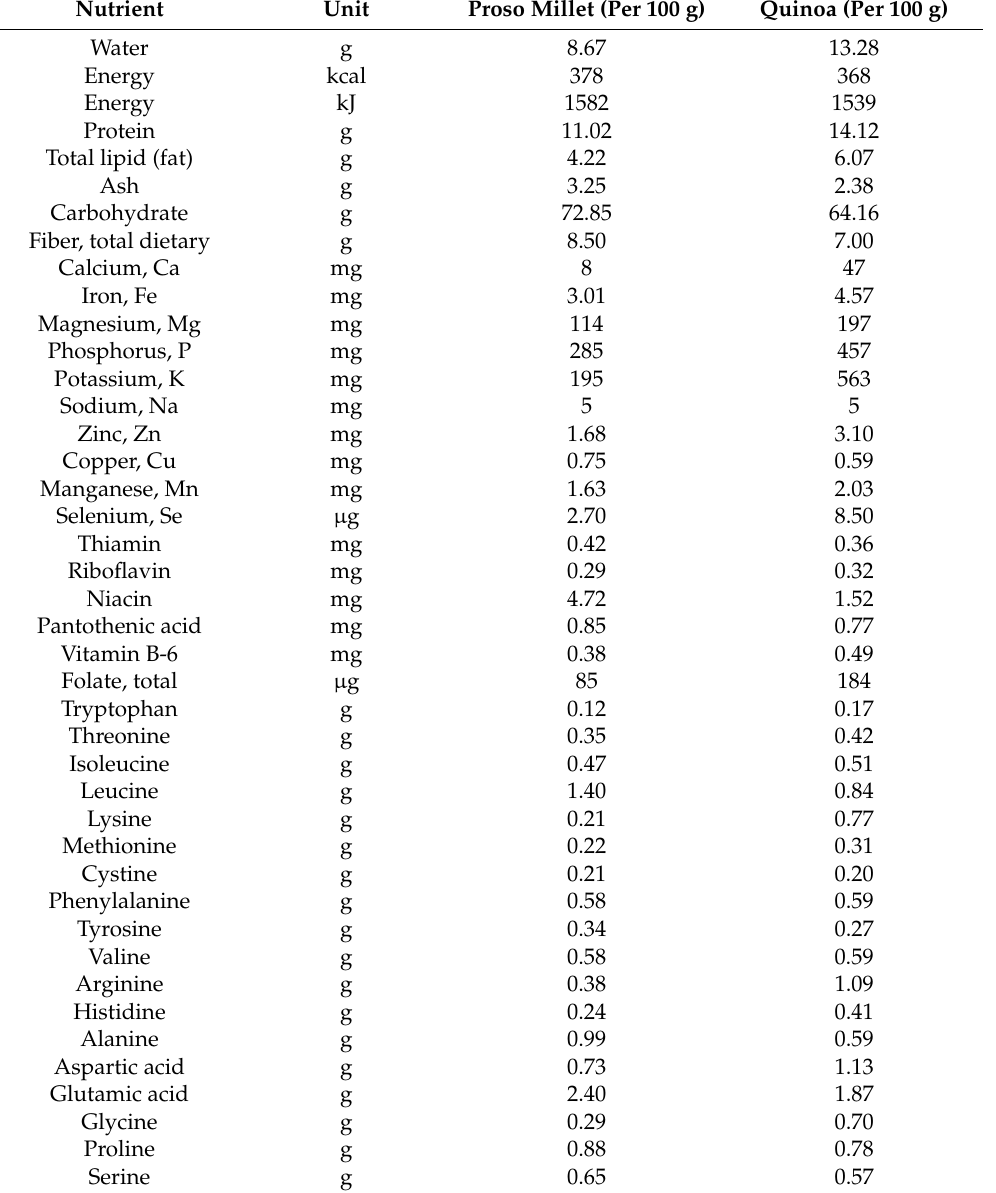
Table 5. Nutritional difference between proso millet and